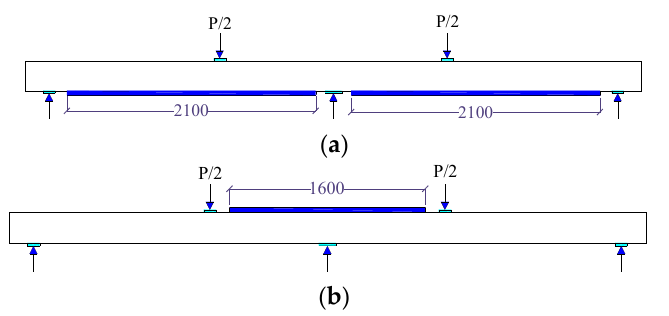
Figure 4. Strengthening regime (dimensions are in mm): ( a ) sagging strengthening (group A); ( b ) hogging strengthening (group B).